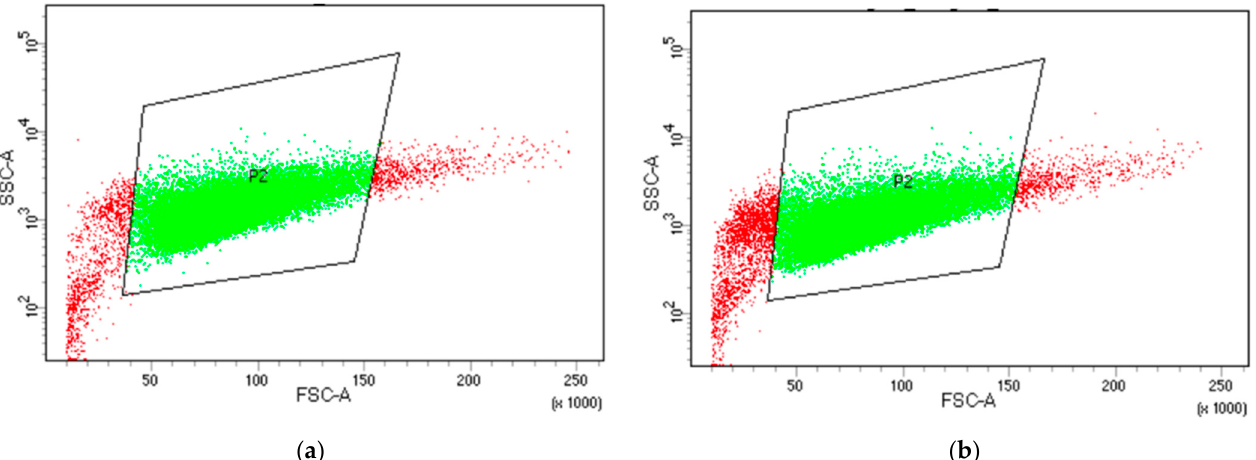
Figure 9. Forward scatter vs. side scatter for ( a ) control cell population and ( b ) cells exposed to 50 μ g/mL AuNP suspension for 24 h. Forward vs. side scatter is commonly used to identify the size of cells and particulates. If nanoparticles were large or aggregated and internalized, the side scatters would increase dramatically.